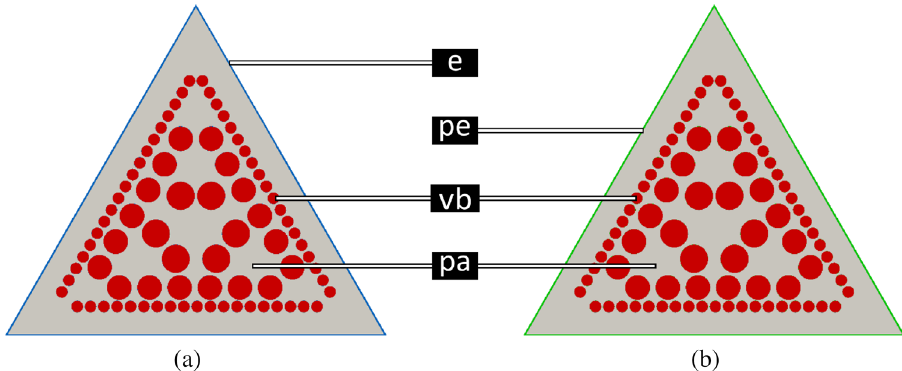
Figure 2. Initial configuration. Parenchyma and vascular bundles surrounded by ( a ) an epidermis ( E norm = 0.00111 ) and ( b ) a peridermal covering tissue ( E norm = 0.01111 ), respectively. For a non-lignified epidermis, both the torsional and flexural rigidity are comparatively low. If a corky periderm is formed, the flexural rigidity is increased by ≈ 14% and so is the torsional rigidity increased by ≈ 46% . This leads to a decrease in the twist-to-bend ratio by ≈ 24% . Abbreviations and colour code: e: epidermis (blue), pa: parenchyma (grey), pe: periderm (green), vb: vascular bundles